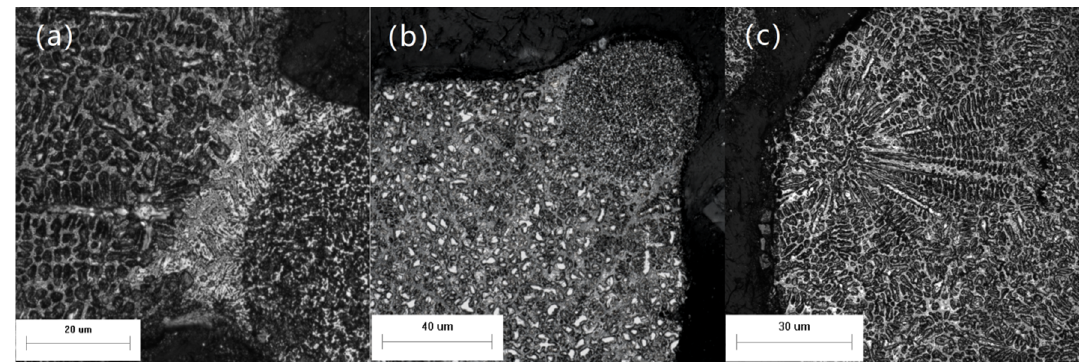
Figure 8. Typical combination forms of powders: ( a ) not embedded; ( b ) partially embedded; ( c ) completely embedded.